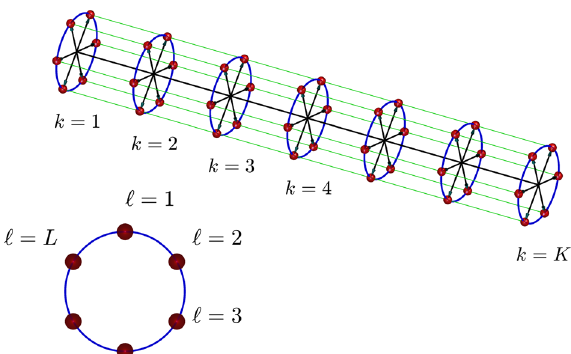
Fig. 1 Schematic diagram illustrating the geometry of a multiplet line